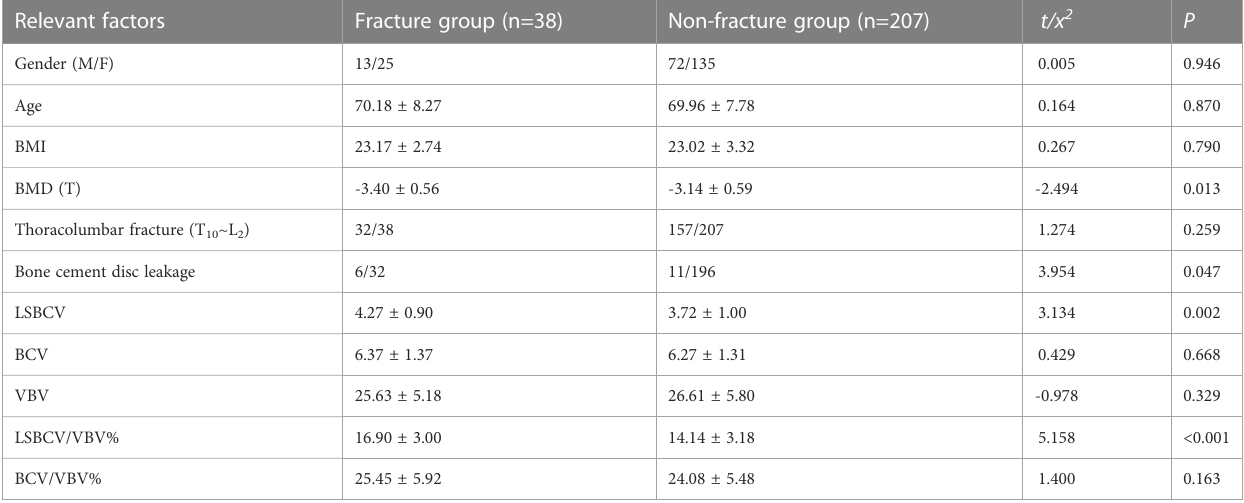
TABLE 1 Univariate analysis that affects AVCF.